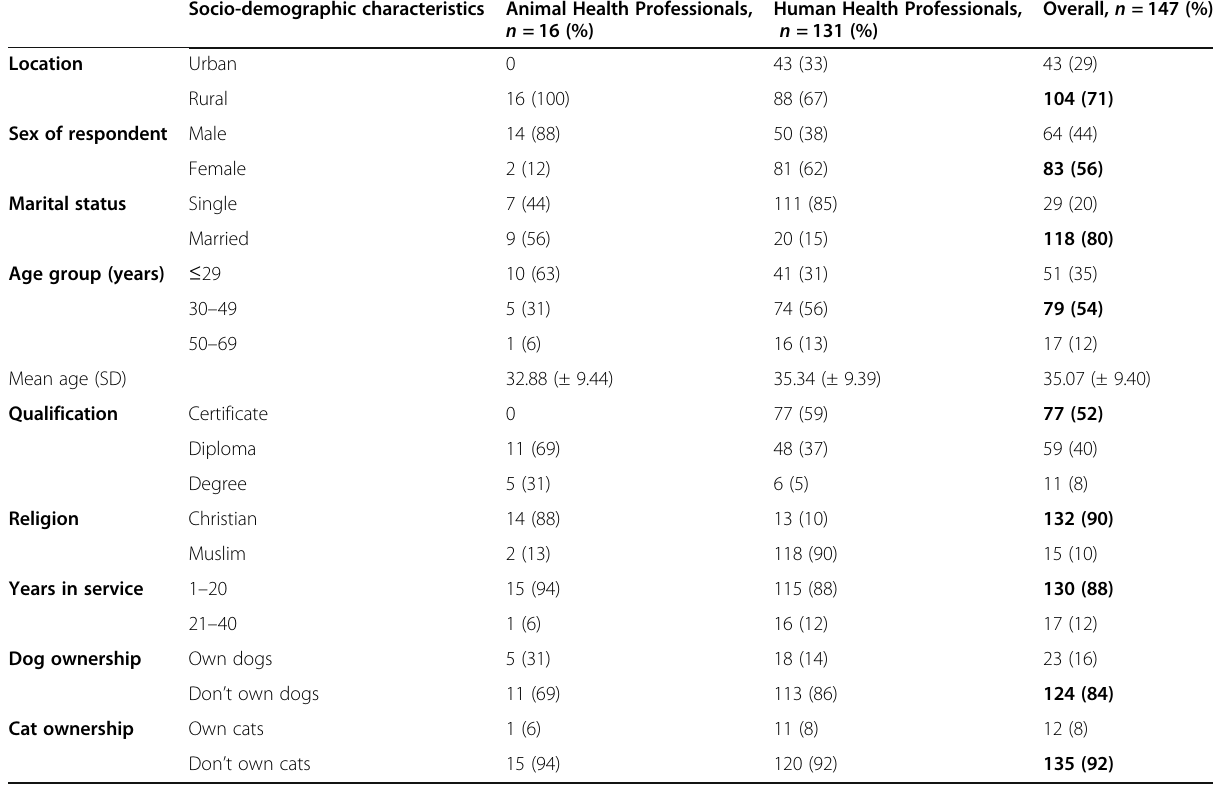
Table 1 Socio-demographic characteristics of animal and human health workers Socio-demographic characteristics Animal Health Professionals, Human Health Professionals, n = 16 (%) n = 131